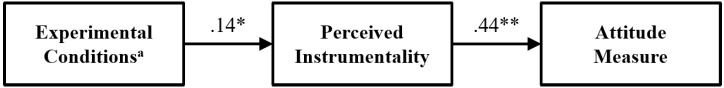
Results from the path analysis (Study 3). a0 = unifinal means; 1 = counterfinal means. ∗∗p < 0.001, ∗p < 0.05.